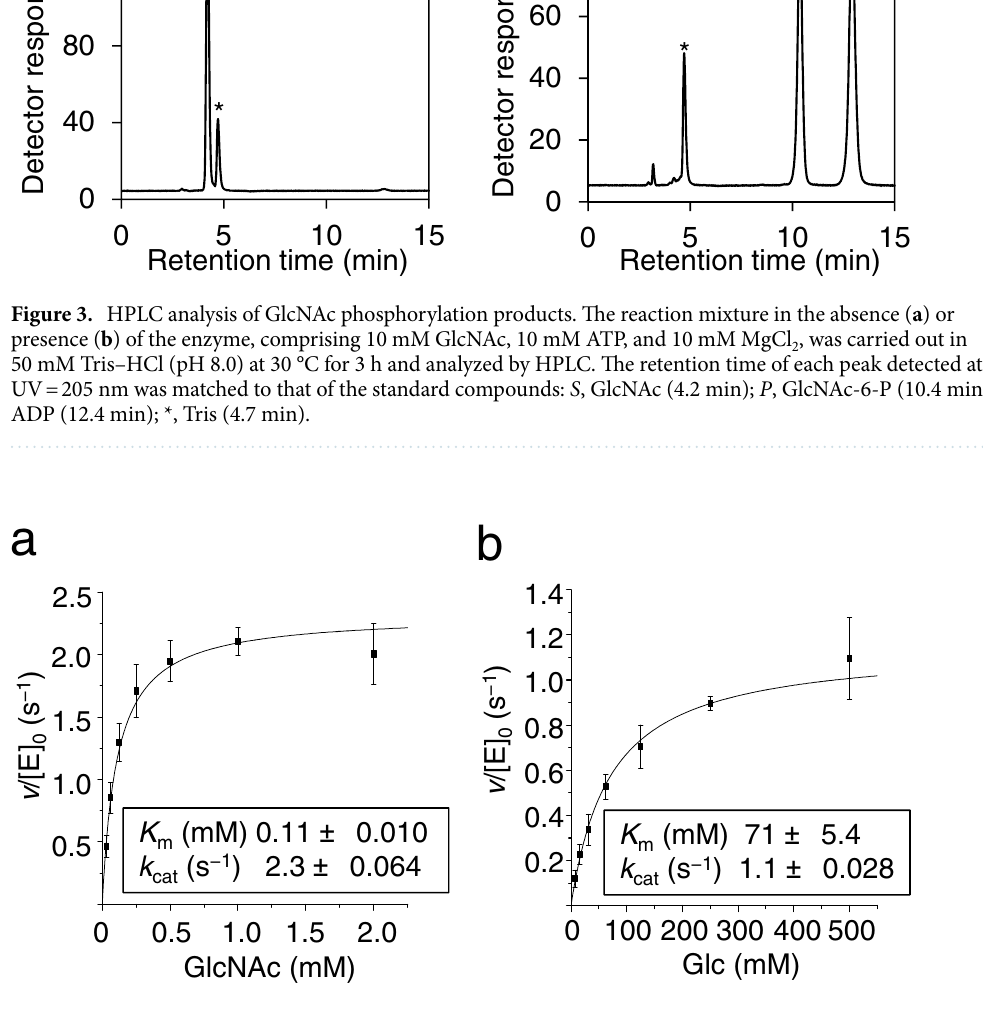
Figure 4. YLR446W encodes a GlcNAc kinase named Ngk1. Kinetic analysis of Ngk1 kinase activity of GlcNAc ( a ) and Glc ( b ) was carried out using a pyruvate kinase and lactate dehydrogenase coupled